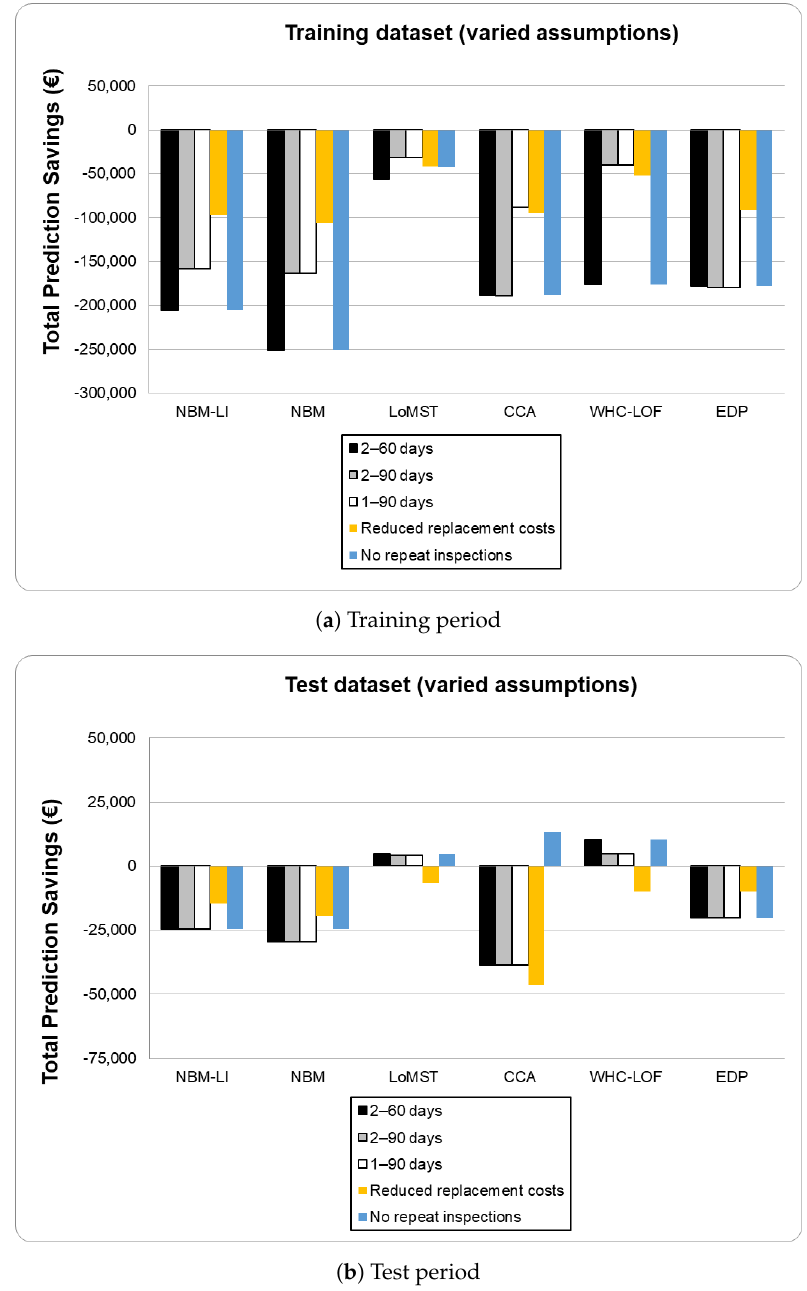
Figure 14. Effect of variations on Total Prediction Savings (TPS) for each